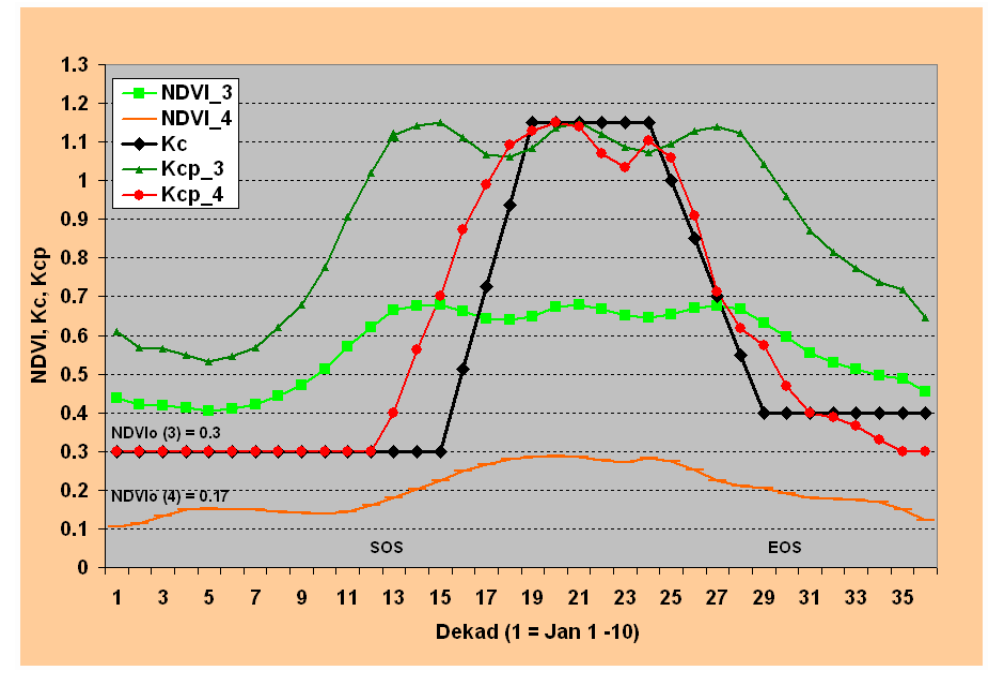
Figure 3. Temporal profile of AVHRR NDVI climatology, corresponding Kcp, and control Kc profiles for two noncropland locations with different proportion of bare (B), herbaceous (H), and tree (T) cover percentages. NDVI_3: B = 0%, H = 62%, T = 38; NDVI_4: B = 42%, H= 58%,